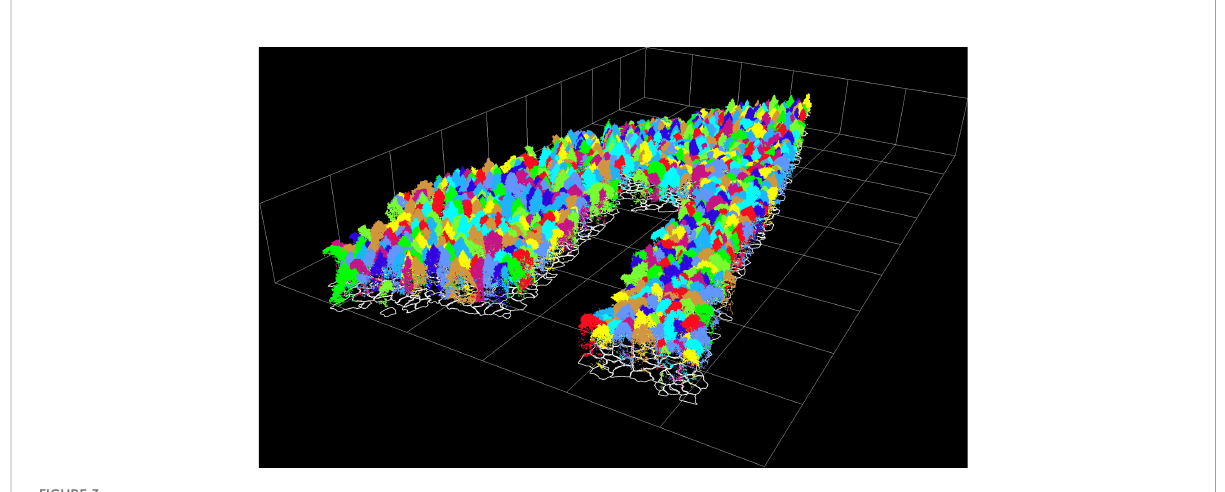
FIGURE 3 The point cloud and the projection pro fi le of individual